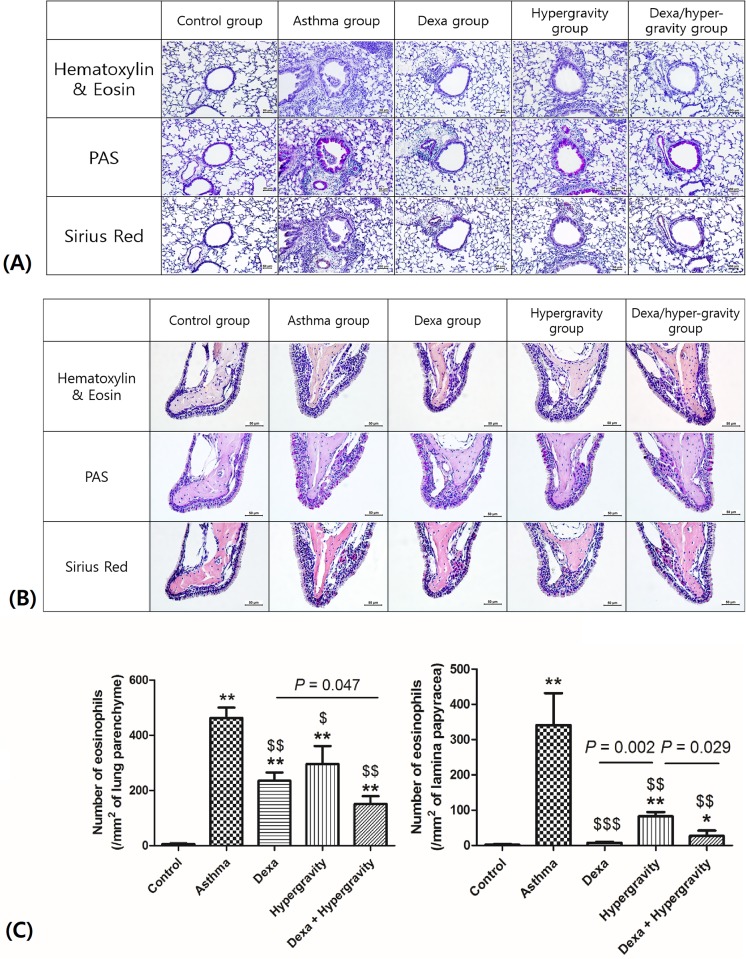
Histological observations of the lung and nasal cavity (upper column, Figs 5a_1 and 5a_2), and the number of infiltrated eosinophils into 1 mm2 of lung parenchyma and lamina papyracea of the nasal cavity (lower column, Fig 5b).* Significant difference from the control group, p < 0.05; ** significant difference from the control group, p < 0.01; $ significant difference from the asthma group, p < 0.05; $ $ significant difference from the asthma group, p < 0.01; $ $ $ significant difference from the asthma group p < 0.001 (the Kruskal-Wallis and Mann-Whitney U tests).